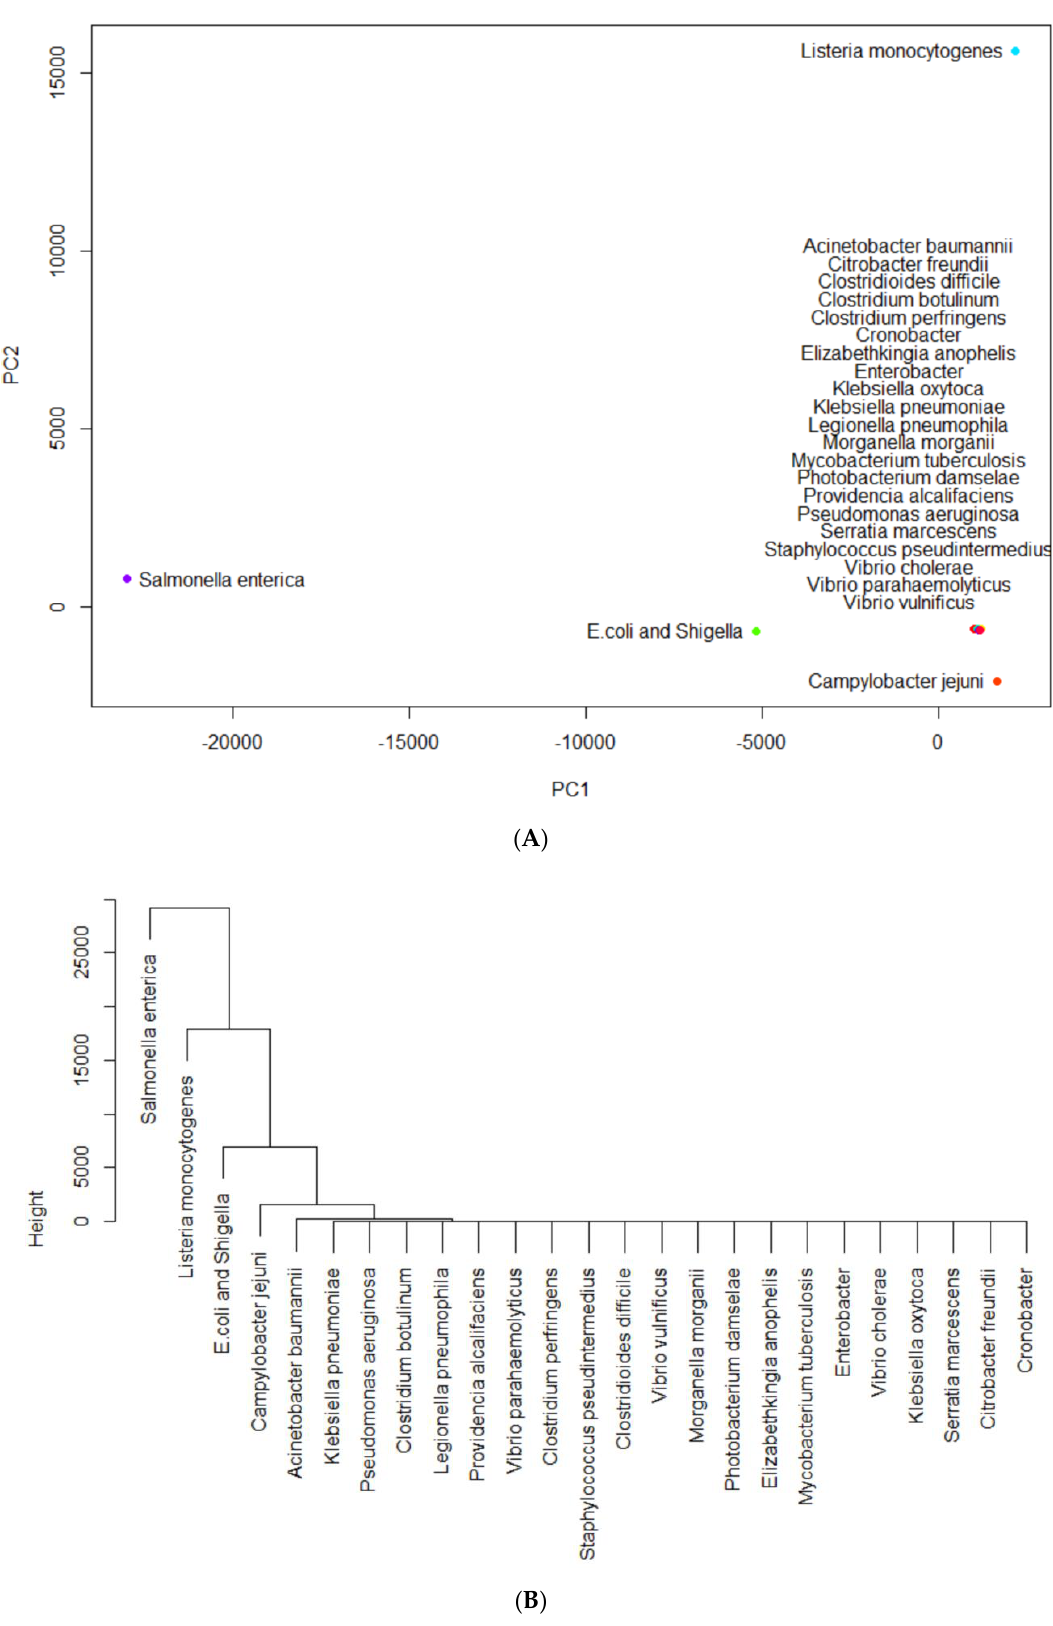
Figure 3. An illustrative example of PCA and hierarchical clustering: ( A ) projections of pathogens onto the PC1-PC2 space based on the resistance of antimicrobials; ( B ) clustering the pathogens based on their projections in ( A ).